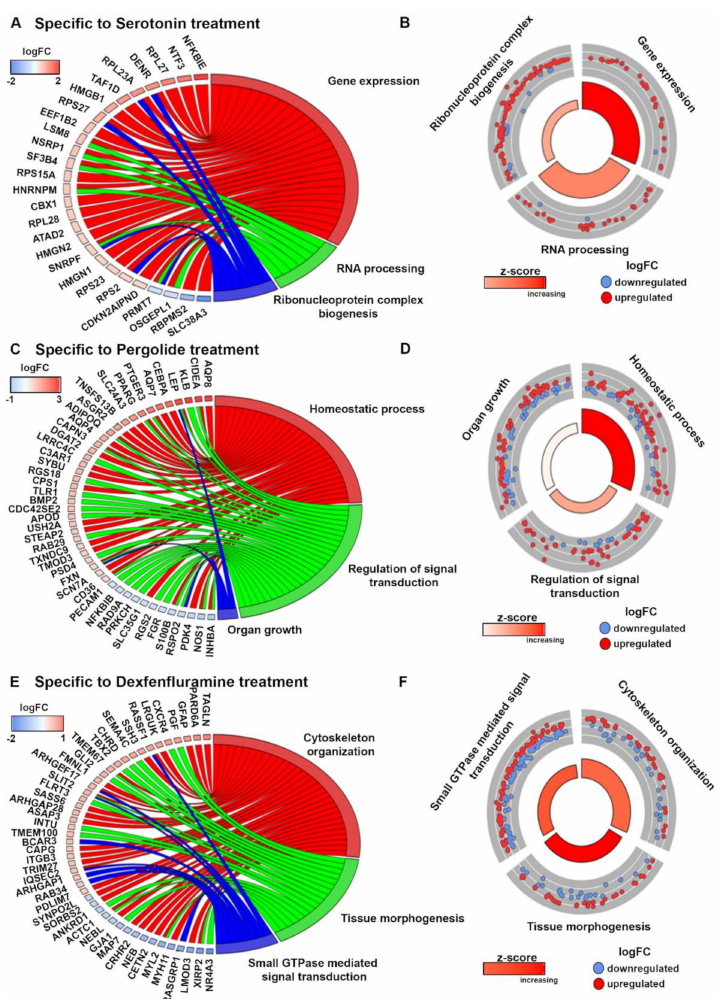
Figure 5. Enrichment of specific biological processes by each treatment. ( A ): Chord plot indicates specific DEGs for serotonin treatment with at least a 1.5-fold change compared to control